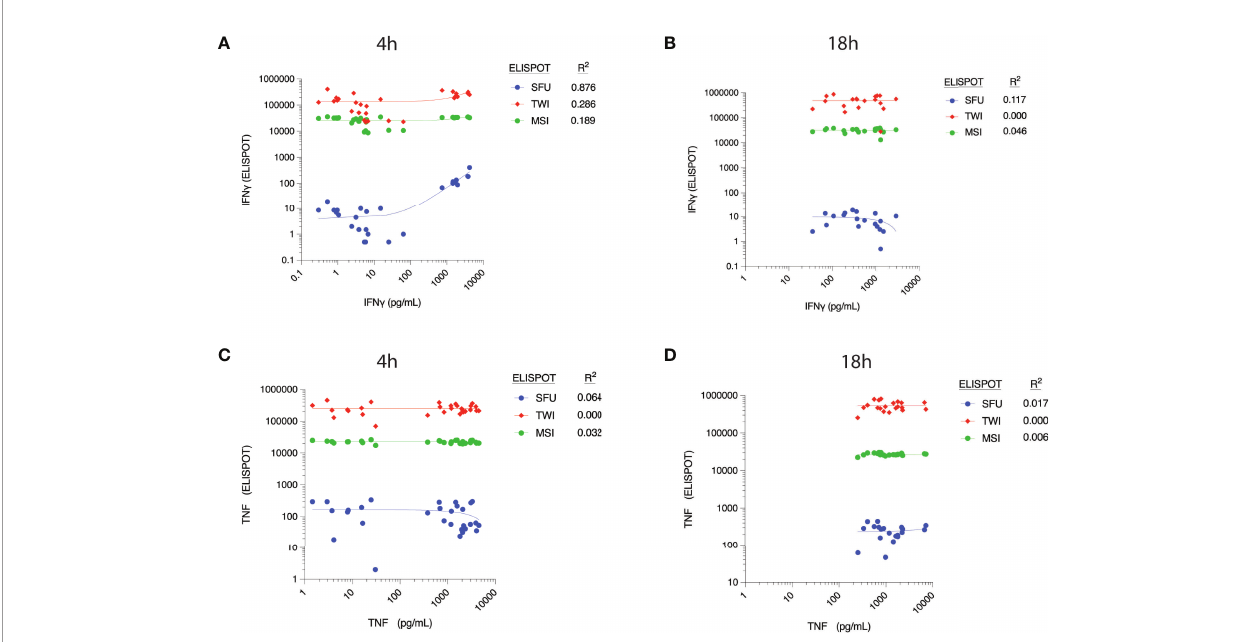
FIGURE 3 | Correlation between cytokine concentrations, as measured by ELLA micro fl uidic immunoassay (x-axis), and different parameters measured by ELISpot assay at 4h post- ex vivo stimulation. Measured plasma cytokine concentration of Interferon (IFN) g versus corresponding ELISpot spot forming units (SFU), Total Well Intensity (TWI) and Mean Spot Intensity (MSI) at (A) 4 hours and (B) 18 hours of stimulation. Measured plasma cytokine concentration of Tumor Necrosis Factor (TNF) versus corresponding ELISpot spot forming units (SFU), Total Well Intensity (TWI) and Mean Spot Intensity (MSI) at (C) 4 hours and (D) 18 hours of